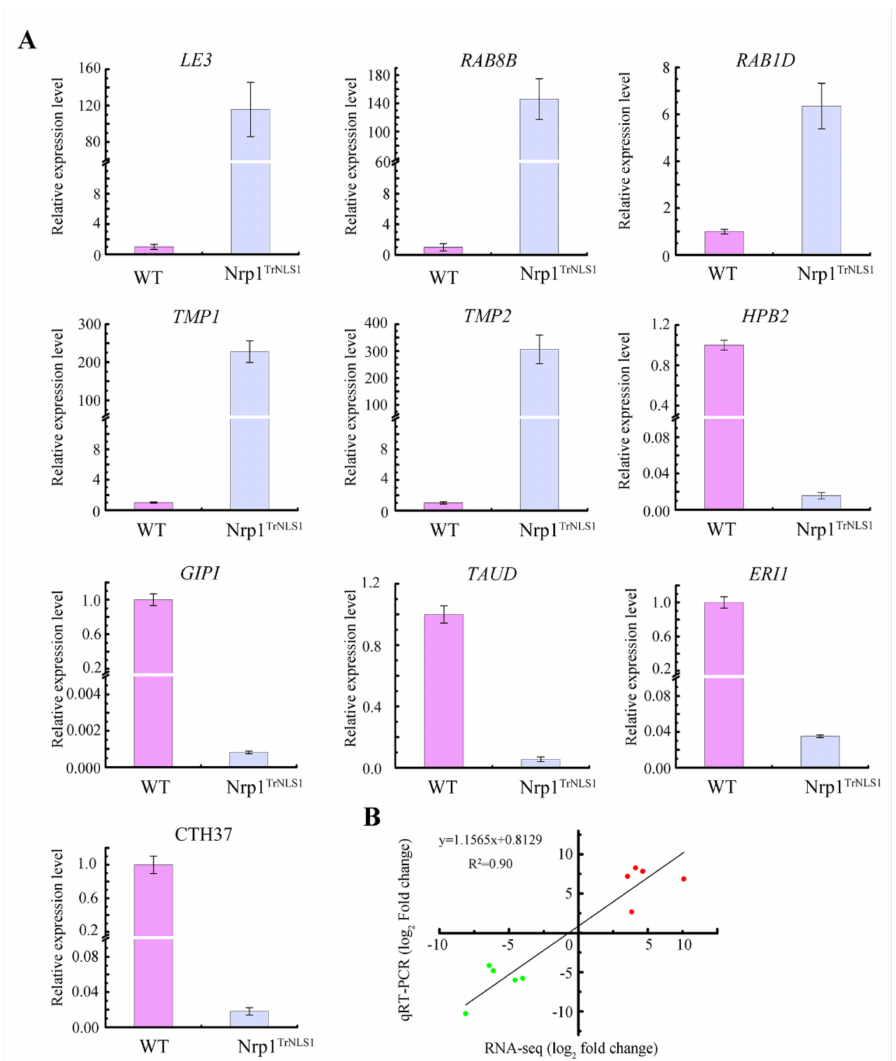
Figure 7. Relative expression level of 10 differentially expressed genes. ( A ) The expression level of 10 genes was determined by qRT-PCR. ( B ) Comparison of the log2 of gene expression ratios obtained between the RNA-Seq data and qRT-PCR. The qPCR log 2 value of the expression ratio ( y -axis) was plotted against the value from the RNA-Seq ( x -axis). R 2 represents the correlation coefficient between qRT-PCR and